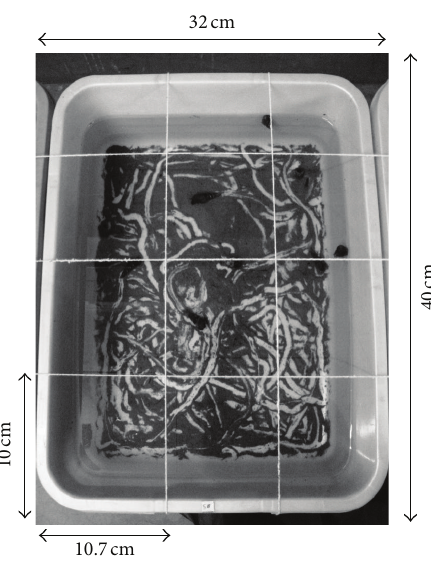
Figure 2: A typical “ Bunty tub” used in the experiments, elaborating the “quadrats” from top view. The dashed lines represent the threads attached to the edges of the tub, so that from top view each quadrat (rectangular in shape—10.7 × 10 cm 2 ) can be